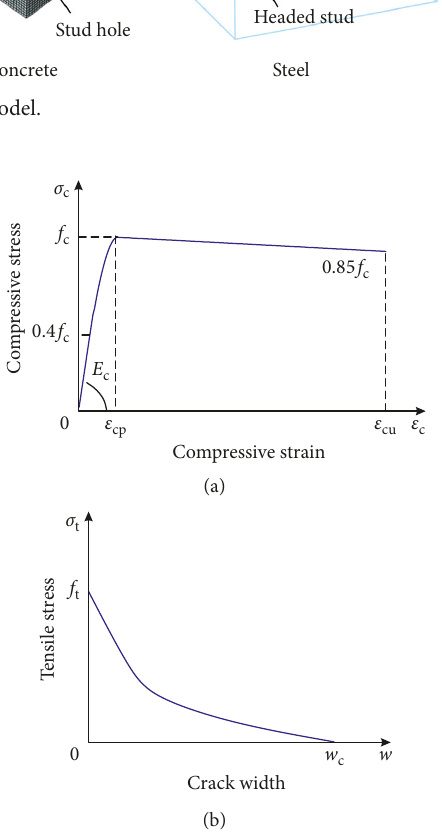
Figure 5: Material modelling of concrete. (a) Compression. (b)